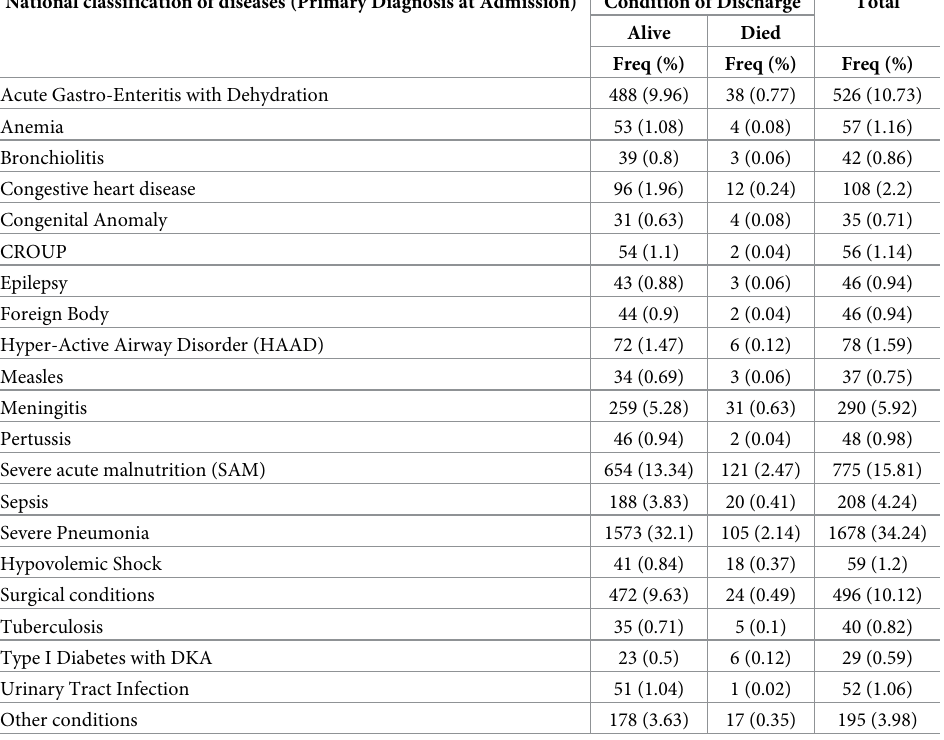
Table 2. National classification of disease with discharge condition for under five children admitted at Asella Referral and Teaching Hospital, January 2020. National classification of diseases (Primary Diagnosis at Admission)